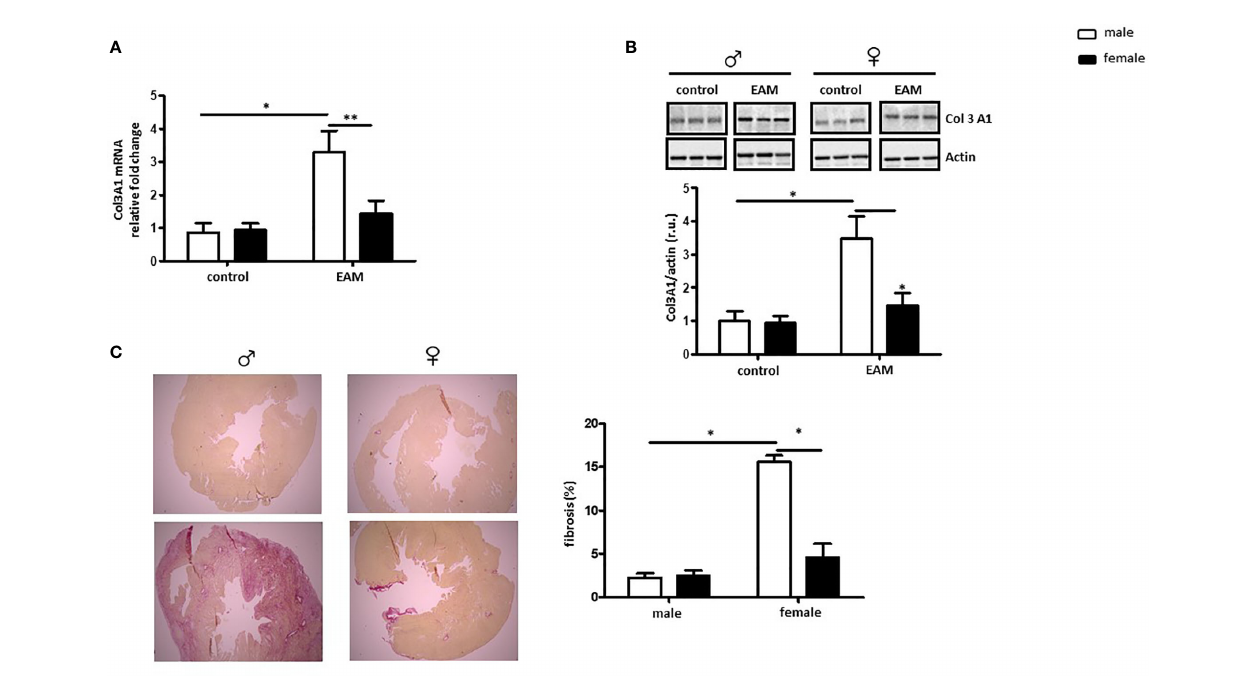
FIGURE 3 | Male EAM rats develop more fi brosis in myocardial tissue. Analysis of Col3A1 mRNA (A) and protein expression (B) in cardiac tissue from control or EAM, male ( ♂ ) and female ( ♀ ). Data are shown as the mean ± SEM (n= 4-12). *p < 0.05, **p < 0.01. Representative imaging of western blot analysis; the lanes were run in the same gel. All data were normalized to the corresponding control and expressed in relative units (r.u.). (C) Representative Sirius red – dyed staining of cardiac tissue of 6 m m from male ( ♂ ) and female ( ♀ ) animals and corresponding statistics showing enhanced fi brosis in EAM rats (n= 4-12). Magni fi cation